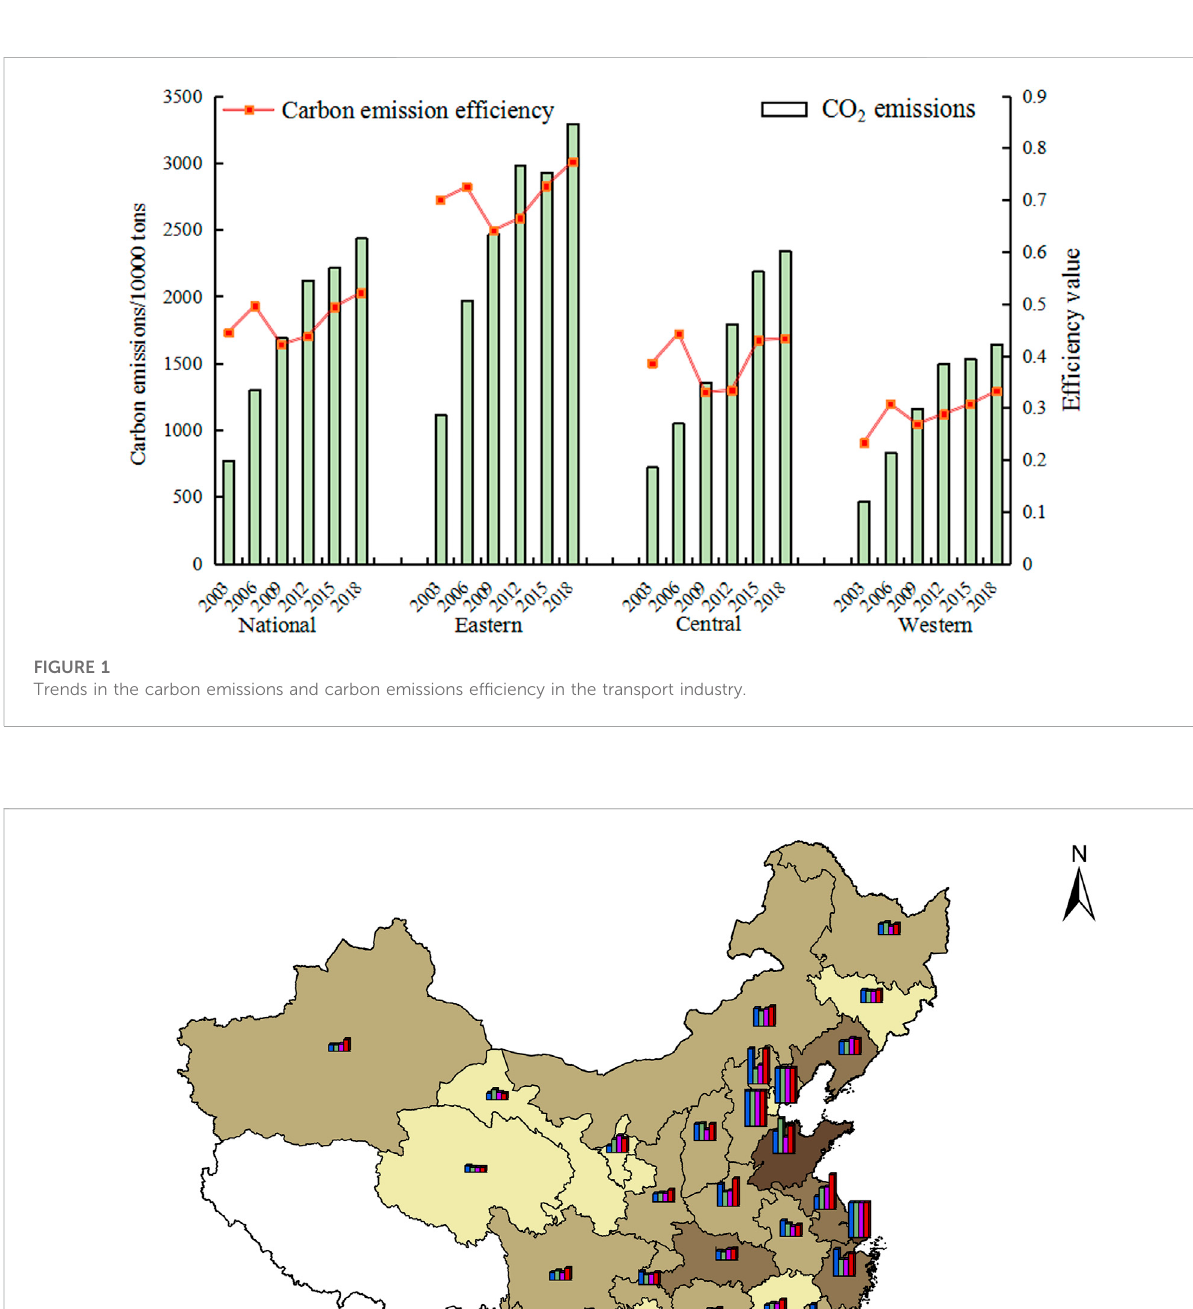
FIGURE 2 Distribution pattern of the carbon emissions and carbon emissions ef fi ciency in the transport industry.